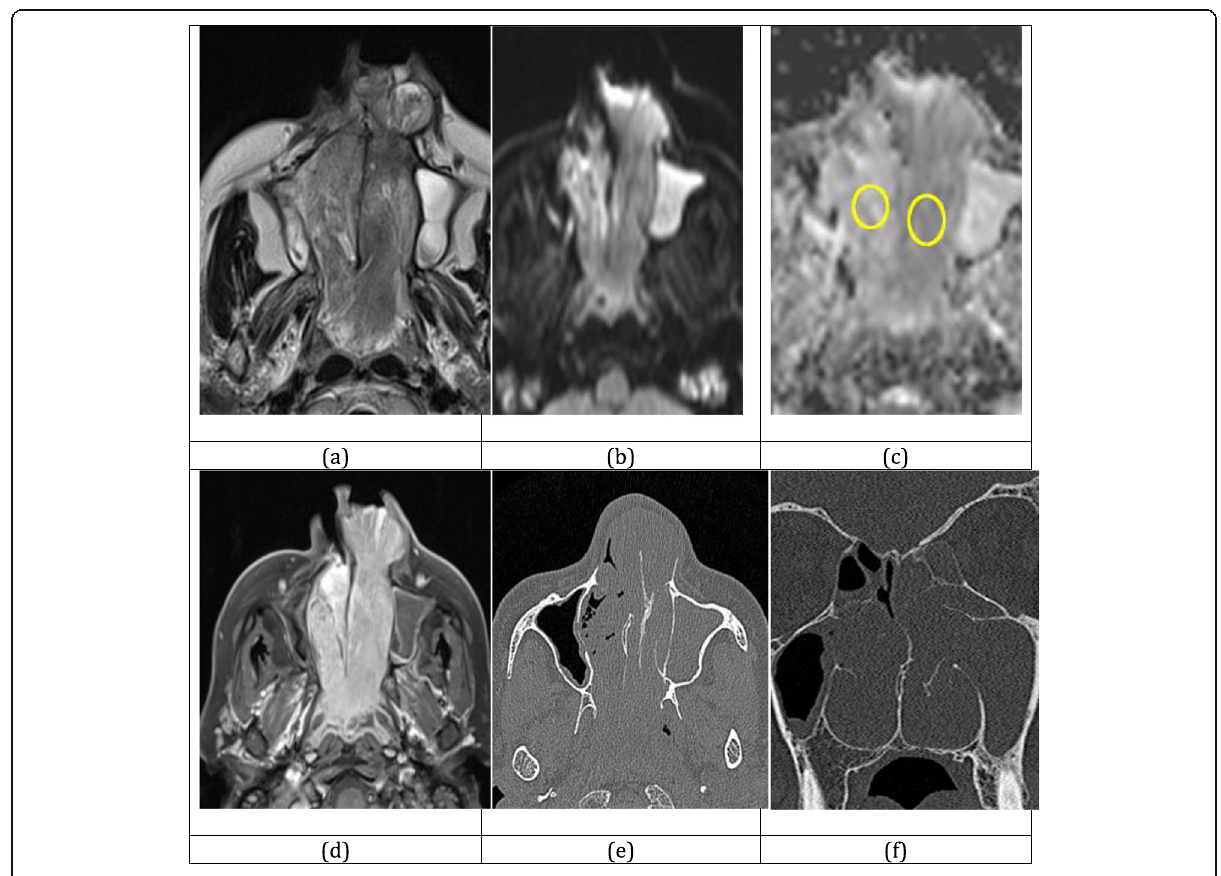
Fig. 3 A 65-year-old female with bilateral nasal obstruction and epistaxis. Axial T2-weighted image ( a ) reveals bilateral bi-nasal inverted papillomas, showing linear divergent and multi-directional sclerosis. Axial diffusion and apparent diffusion co-efficient maps ( a ) and ( b ) reveal an apparent diffusion co-efficient of 1.5 × 10 -3 cm 2 /s. Axial post-gadolinium-enhanced image ( d ) reveals striations less conspicuous than T2 images. Axial computed tomography image reveals smooth mass effect with linear sclerosis at turbinate wall, where striations are divergent in relation to the site of focal hyperostosis. Coronal computed tomography image ( f ) shows the nasal lesions to have considerable intra-antral extensions through widened ostio-meatal units and through rarefied medial wall, as well as through widened post-meatal accessory